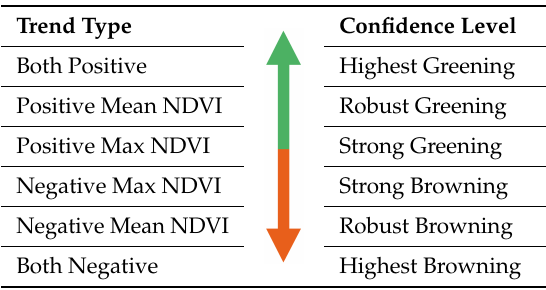
Table 1. The six statistically significant vegetation trend categories and corresponding confidence levels. NDVI refers to the Normalized Di ff erence Vegetation